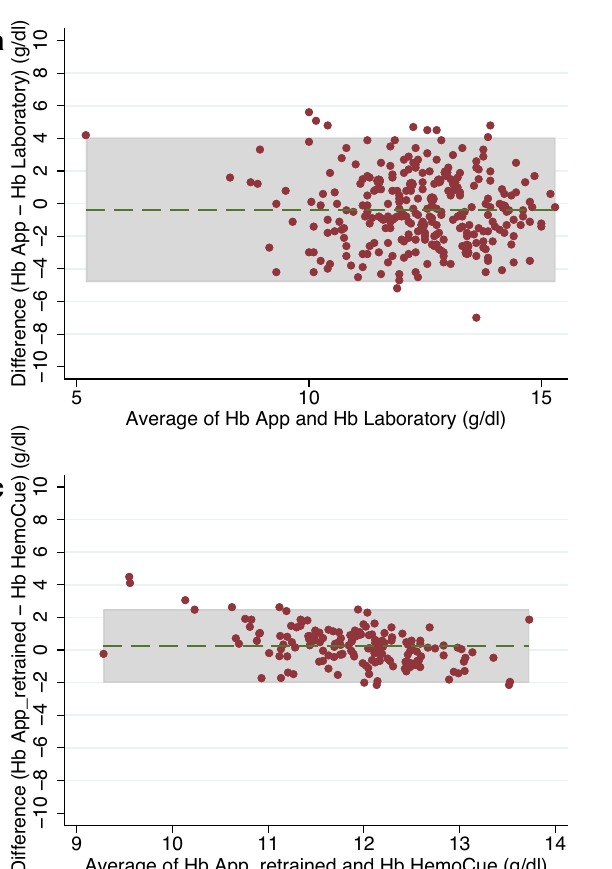
sample is driven by a few outliers within the series of three values for individual children in the pre-school sample. These were caused by sub-optimal pictures when children did not hold their hand in the optimal position. Supplementary Tables 3 and 4 summarize the results of the reliability analysis. Validity after retraining of the App . The mean of the Hb measurements with the retrained App was 12.02 g/dl compared to 11.77 g/dl determined by HemoCue for the same 160 observa- tions (Supplementary Table 2). Using Bland-Altman method, an accuracy of ±2.25 g/dl (95% LoA: − 2.01; 2.50) and a mean